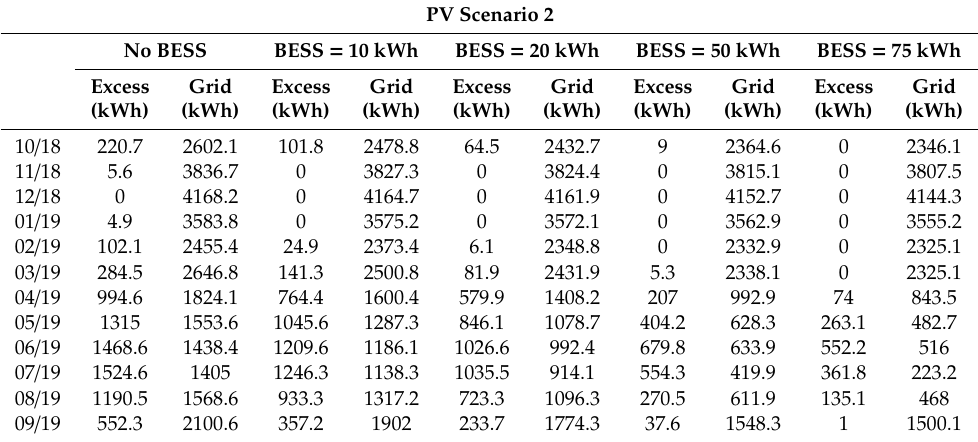
Table A2. Energy sent / taken to / from the grid considering various BESS capacities obtained for PV Scenario 2.